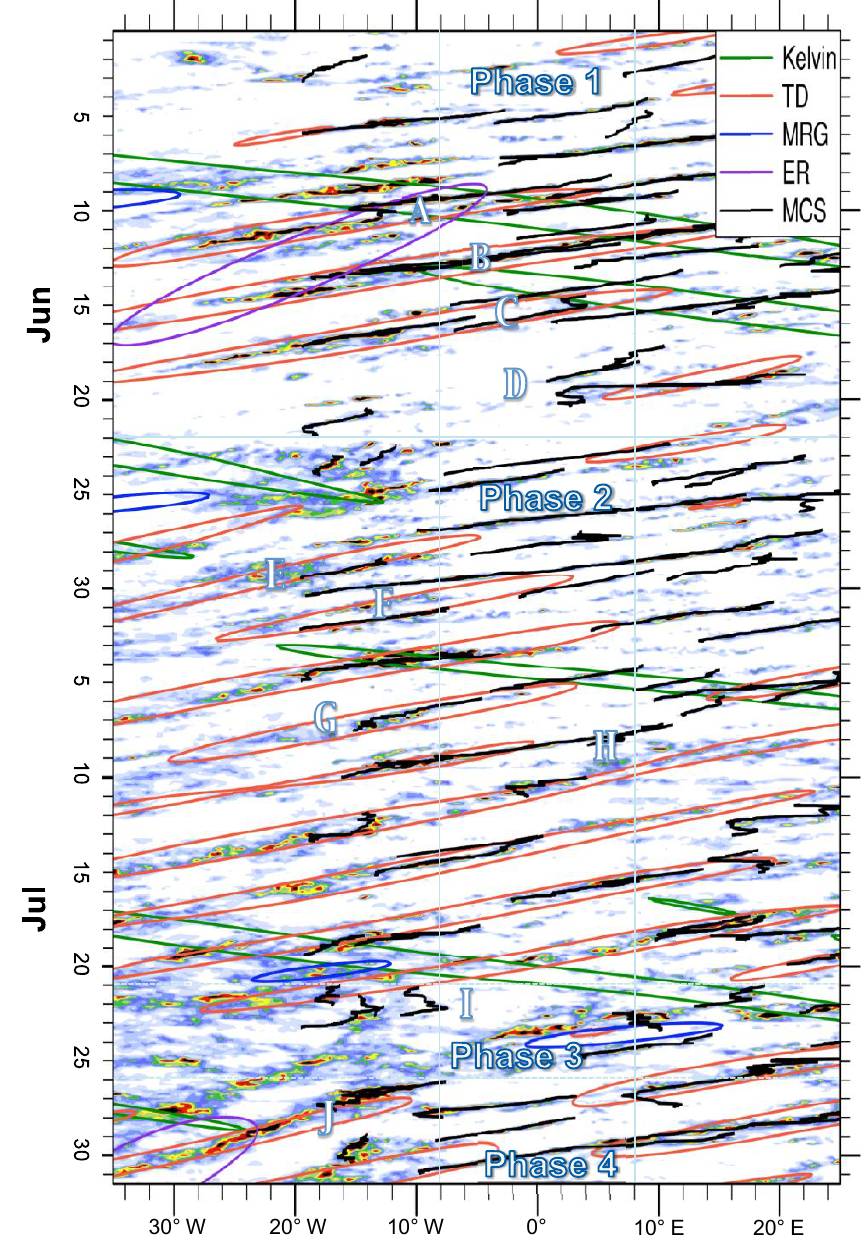
Figure 10. Tropical wave phenomena and long-lived MCSs during June–July 2016. Hovmöller diagram of 5–15 ◦ N meridionally averaged precipitation from TRMM (mmh − 1 , colour shading according to legend) with objectively identified waves marked with coloured lines according to the legend in the top right corner and long-lived MCSs with at least 24h of lifetime marked with thick black lines (for details on detection of both features, see Sect. 2.2). Contour lines for the wave features correspond to a modulation of precipitation of more than 0.12mmh − 1 . Note that while the tropical waves are identified for the entire longitudinal range of 35 ◦ W–25 ◦ E, the MCS identification is limited to the land-dominated area 20 ◦ W–25 ◦ E. The four phases of the DACCIWA campaign and significant synoptic-scale features A–J as well as the longitudinal bounds of the DACCIWA focus region 8 ◦ W–8 ◦ E (see Fig. 1) are